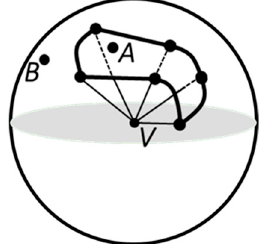
Figure 8. The spherical polygon indicated by the edges sharing a vertex V that the test ray intersects. If the point A corresponds to the ray direction, the ray interpenetrates the polyhedron. If the point B corresponds to the ray direction, the ray does not interpenetrate the polyhedron (redrawn according to [34]).